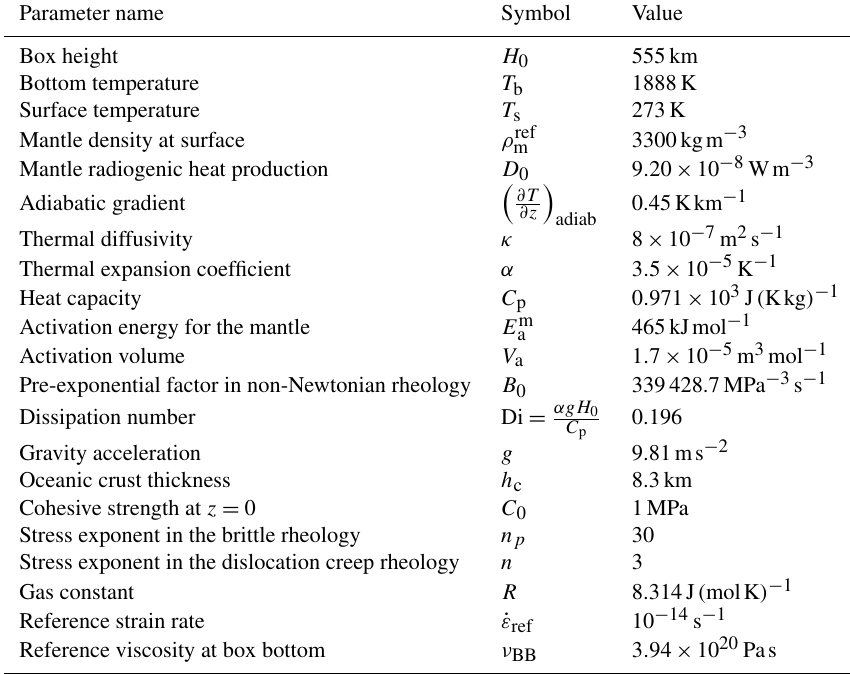
Table 2. Constant names and values. Parameter